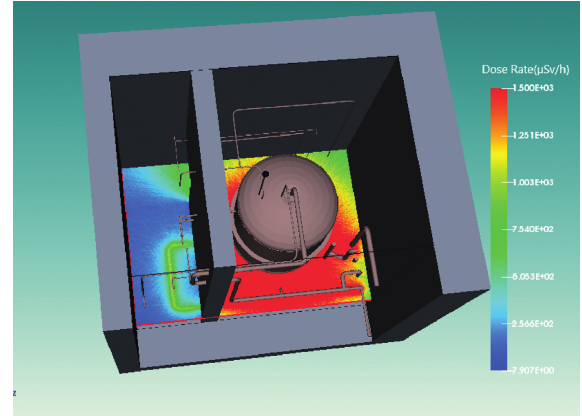
Figure 7: Shielding effect evaluation of labyrinth and door.